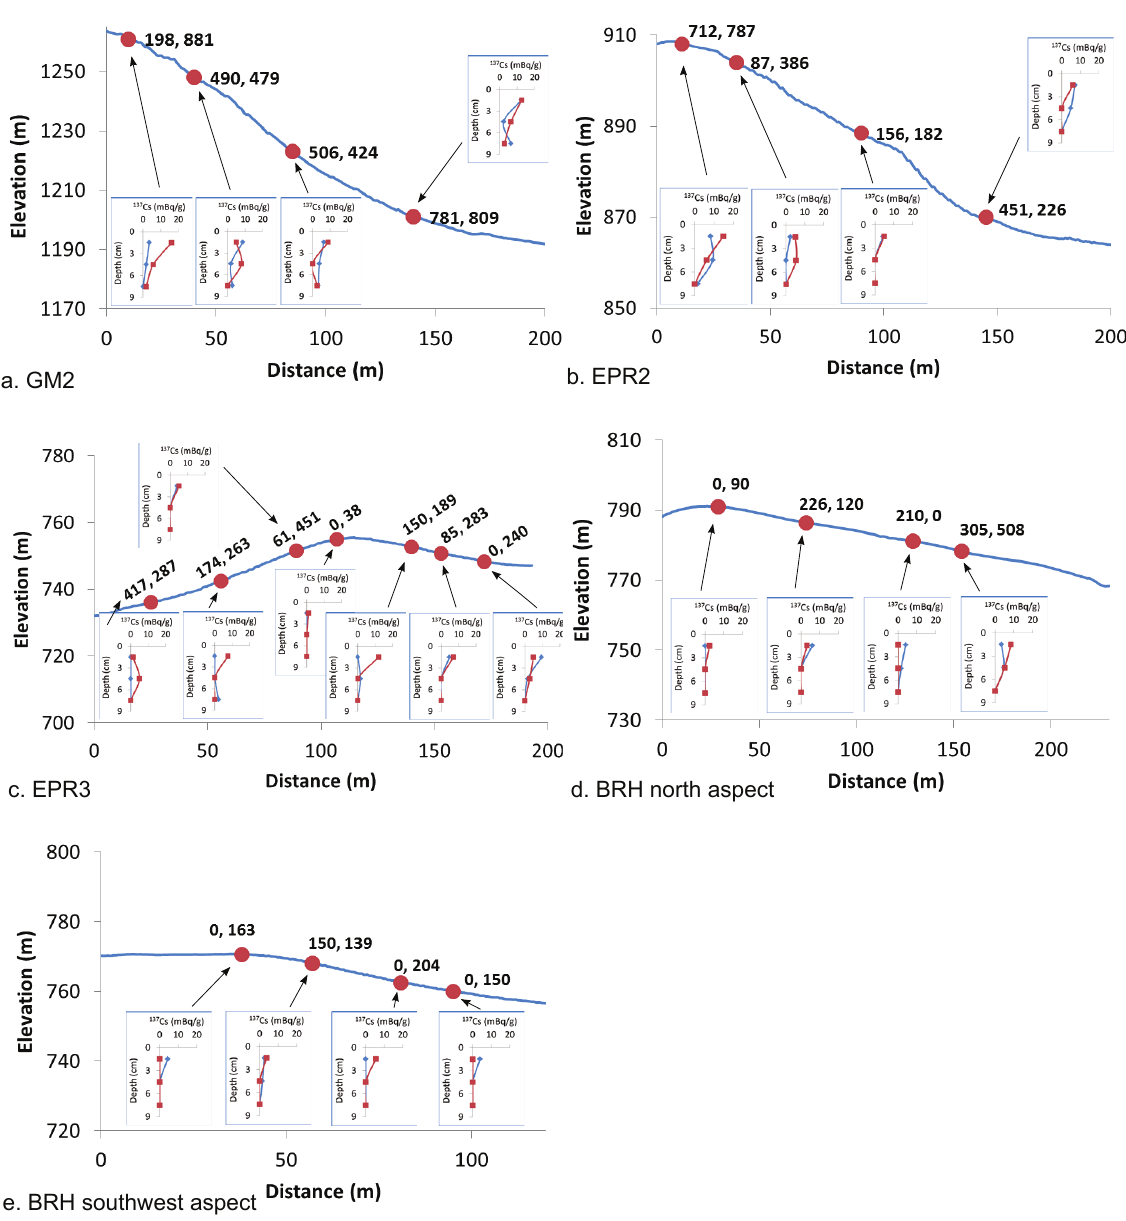
Figure 3. The distribution of total 137 Cs inventories (Bq m − 2 ) per soil pit along the hillslope for each study site: (a) GM2, (b) EPR2, (c) EPR3, (d) BRH, north aspect, (e) BRH southwest aspect. Insets show depth profiles in blue and red of 137 Cs activities (mBqg − 1 ) for the paired soil profiles sampled at each topographic